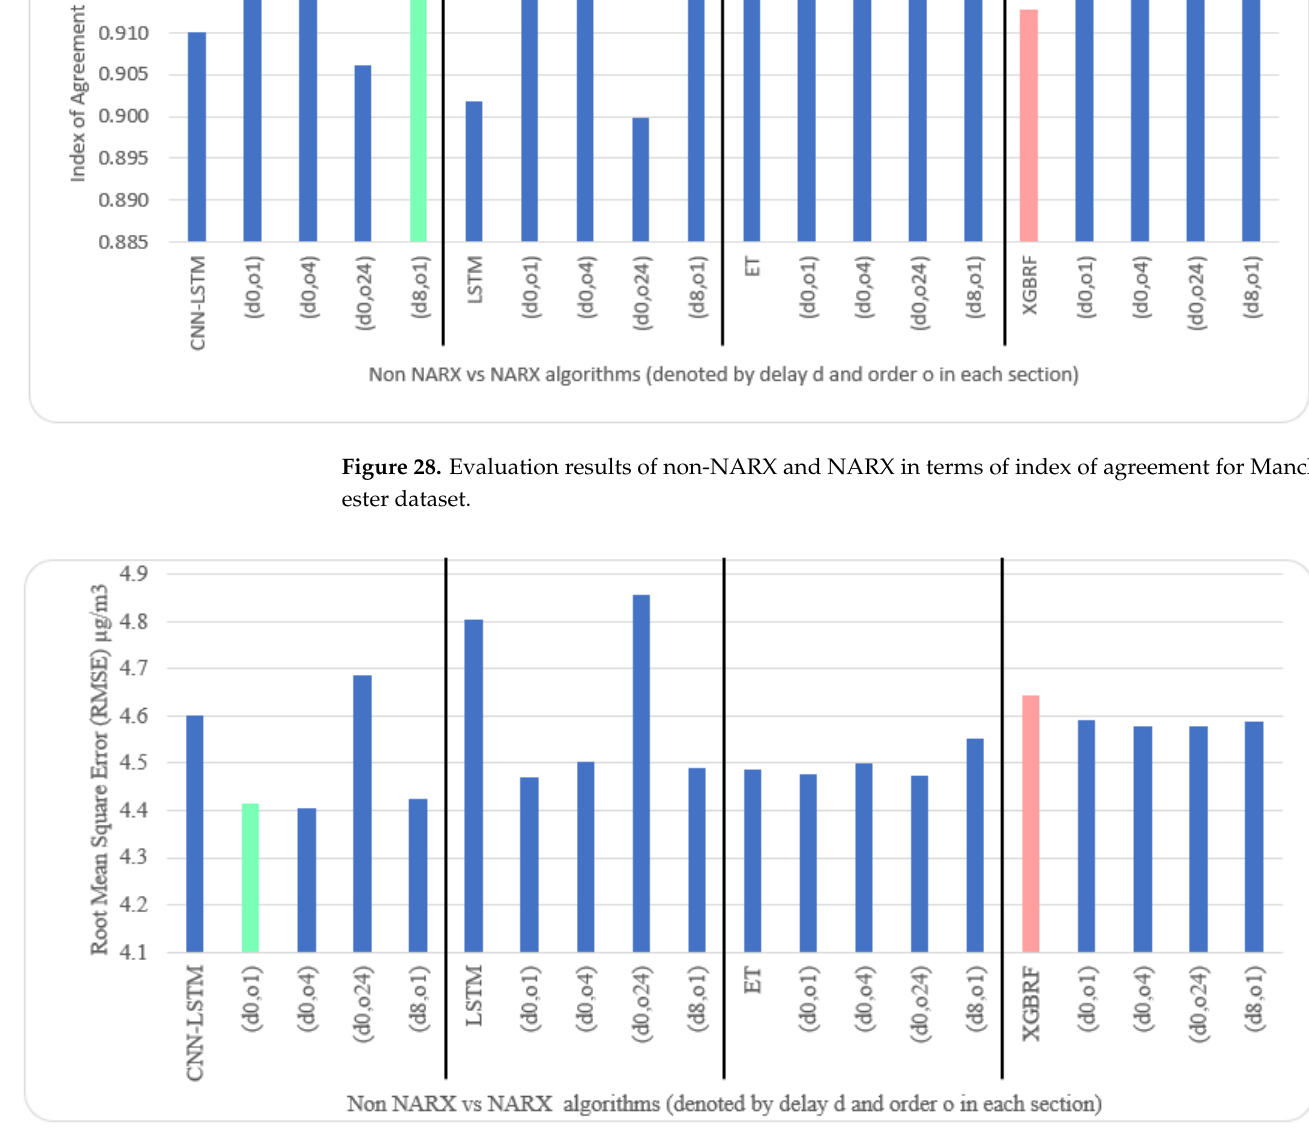
Figure 29. Evaluation results of non-NARX and NARX in terms of root mean square error for the Manchester dataset.